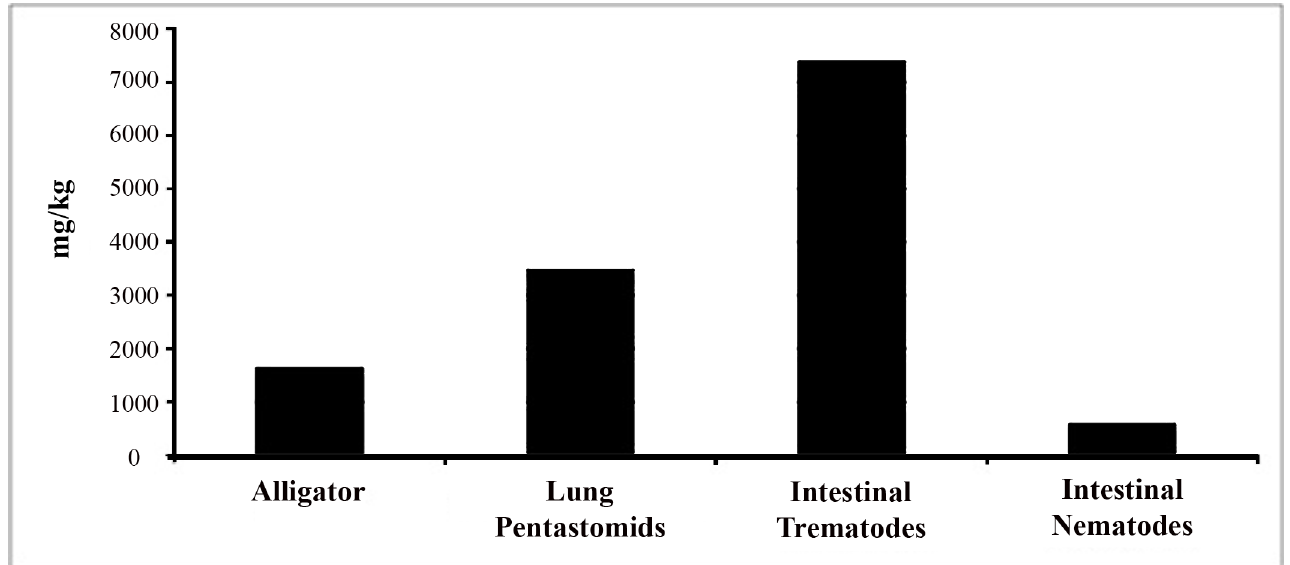
Fig 3. Comparative data of the total heavy metal concentration from an individual alligator from Iberville, Louisiana from the 2011 SELA alligator harvest.